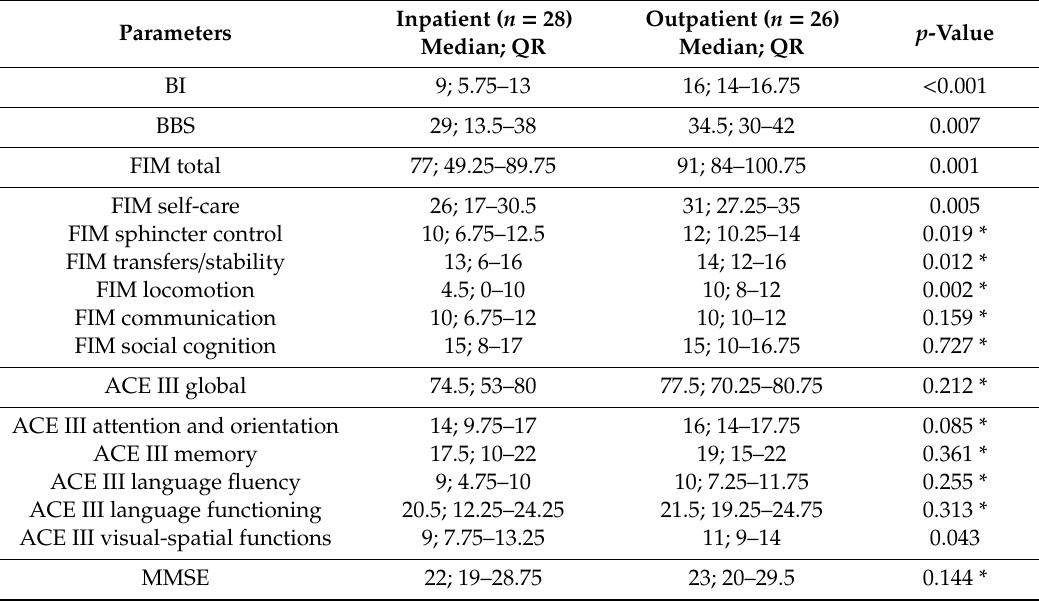
Table 2. Characteristics of functional status of BT patient groups before rehabilitation treatment.